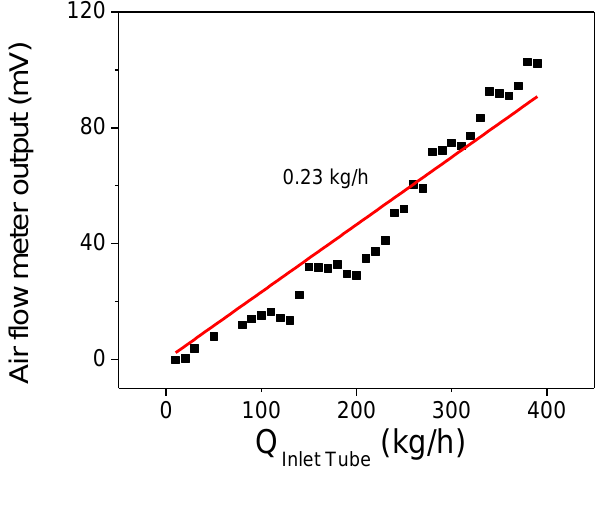
Figure 11. Calibration curve of the present air flow meter mounted in the inlet tube of a truck engine as a function of the measured flow using the commercial air flow meter of [7], mounted in the same truck engine tube. The points are the experimental results, while the red line is the linear fit to these